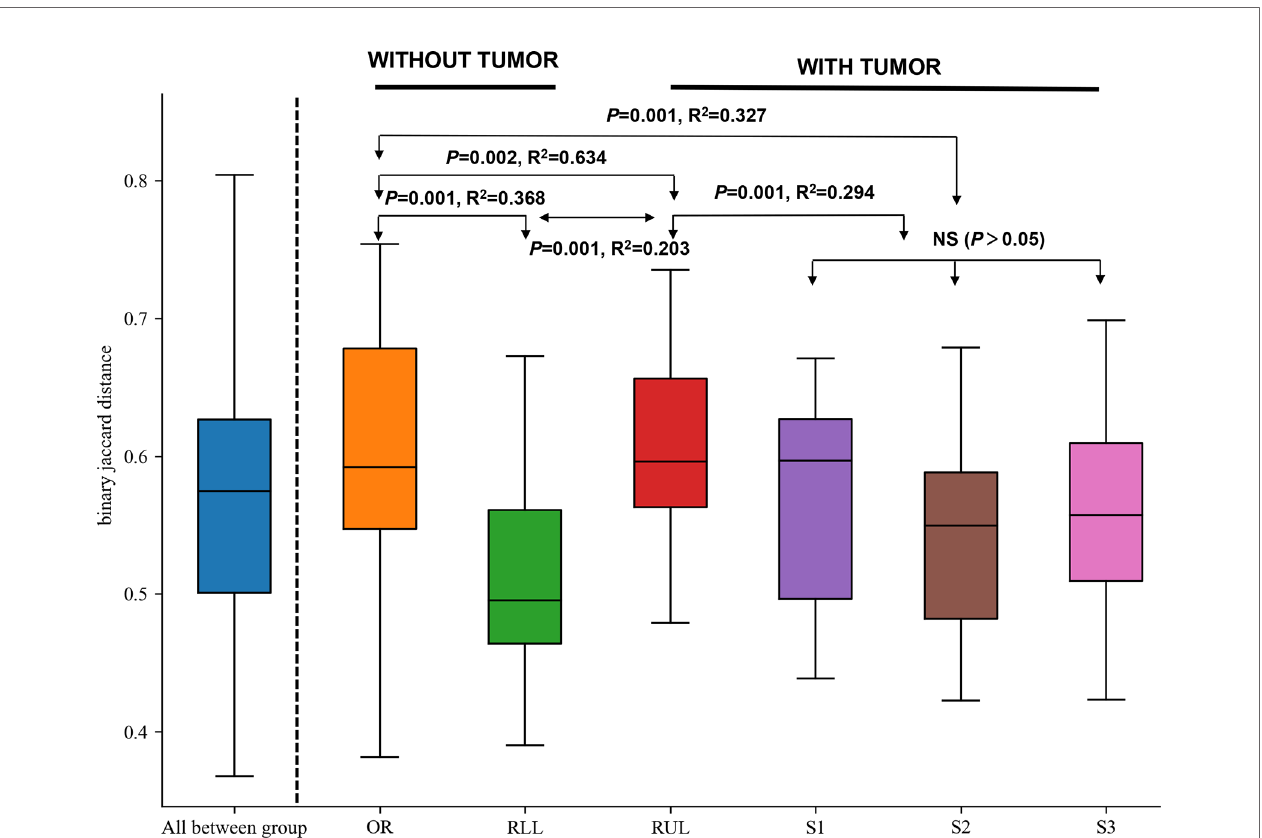
FIGURE 3 | Formal comparisons between regions evaluated by analysis of similarities (ANOSIM) revealed signi fi cant differences between the OR and consecutive sampling regions in the respiratory tract. NS, not signi fi cant; OR, oral cavity; RUL, right upper lobe; RLL, right lower lobe; S1, apical segment; S3, anterior segment; and S2, posterior